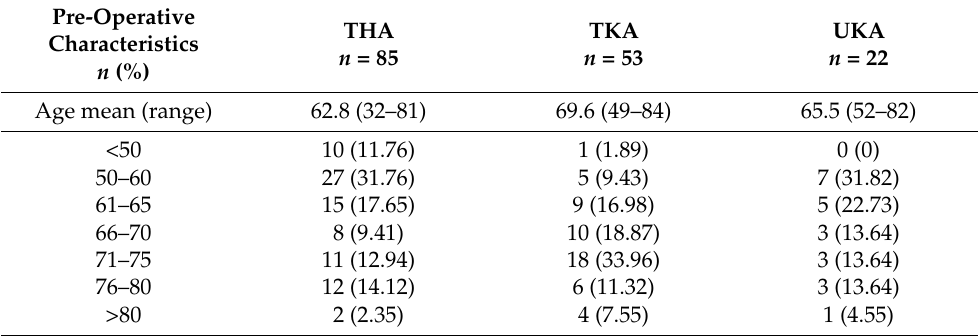
Table 1. Characteristics of patients having received a simultaneous